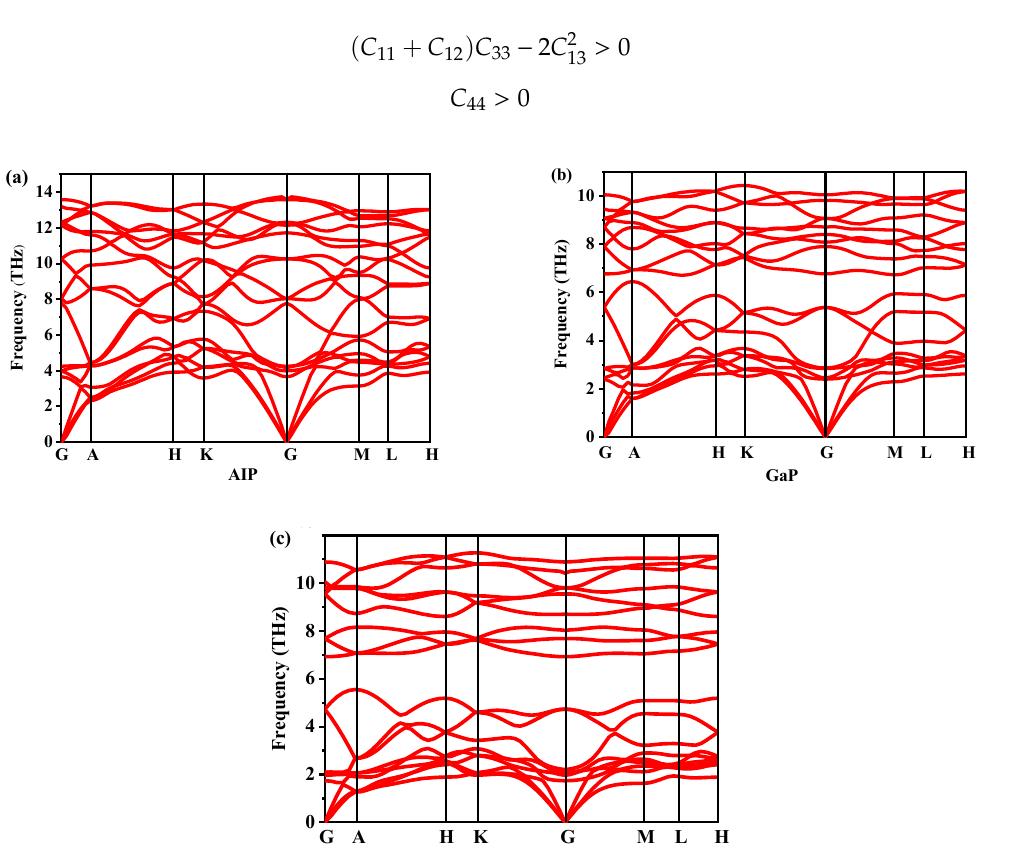
Figure 4. The phonon spectra of P 6 4 22- X P ( X = Al, Ga, or In): AlP ( a ), GaP ( b ), and InP ( c ).